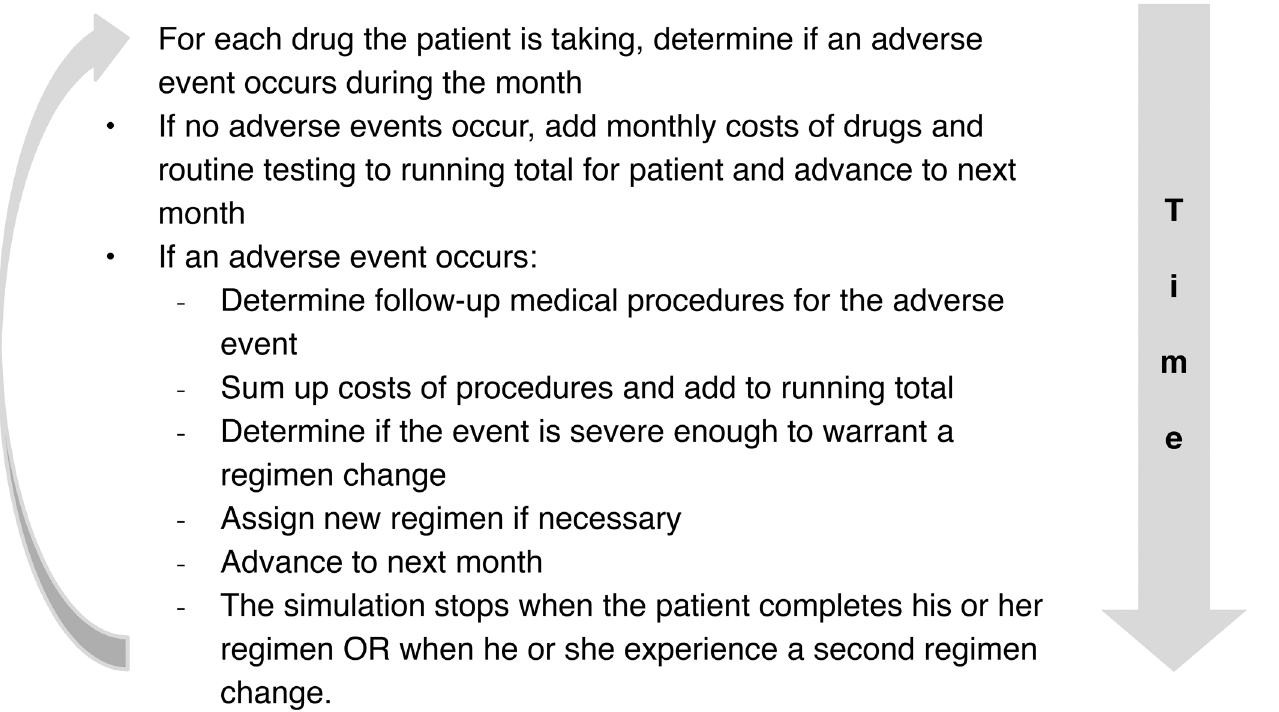
Fig 1. Actions simulated at each monthly time